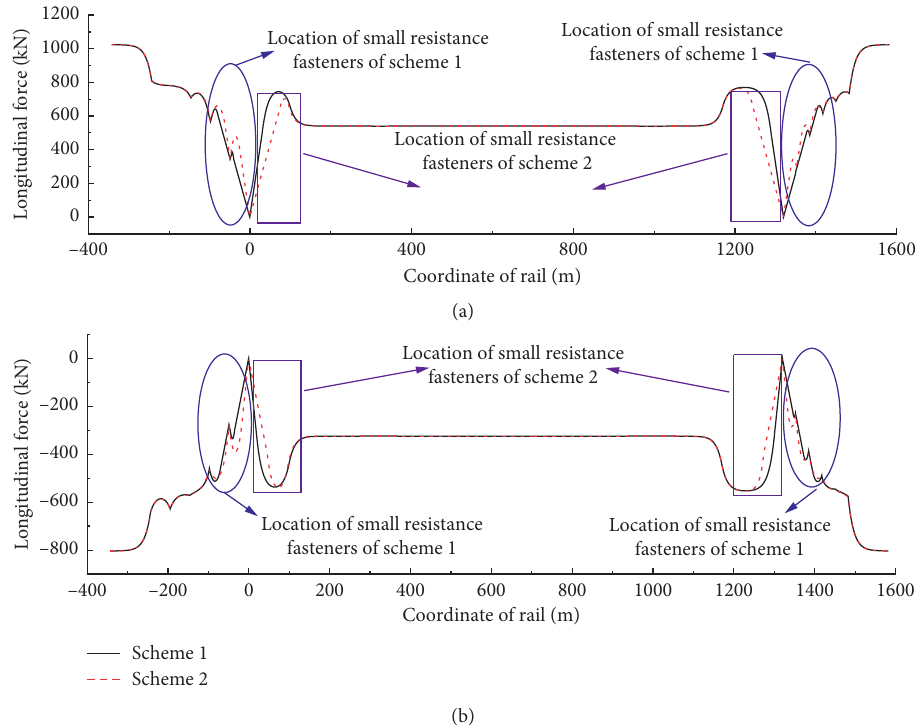
Figure 7: Rail longitudinal force under expansion condition. (a) Temperature dropping. (b) Temperature